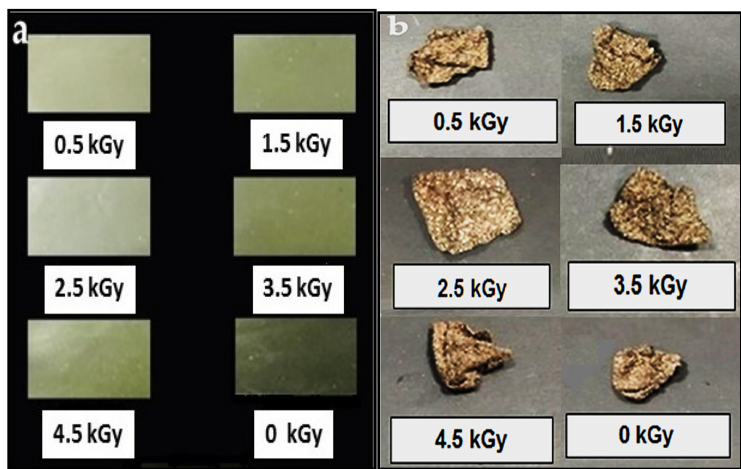
Figure 8. Digital image of the biodegradation test ( a ) before buried in soil and ( b ) after withdrawn from the soil after 50 days for non-irradiated and irradiated seaweed-neem composite films. 3.9. E ff ect of Irradiation Dose on the Antimicrobial Activity of Seaweed-Neem